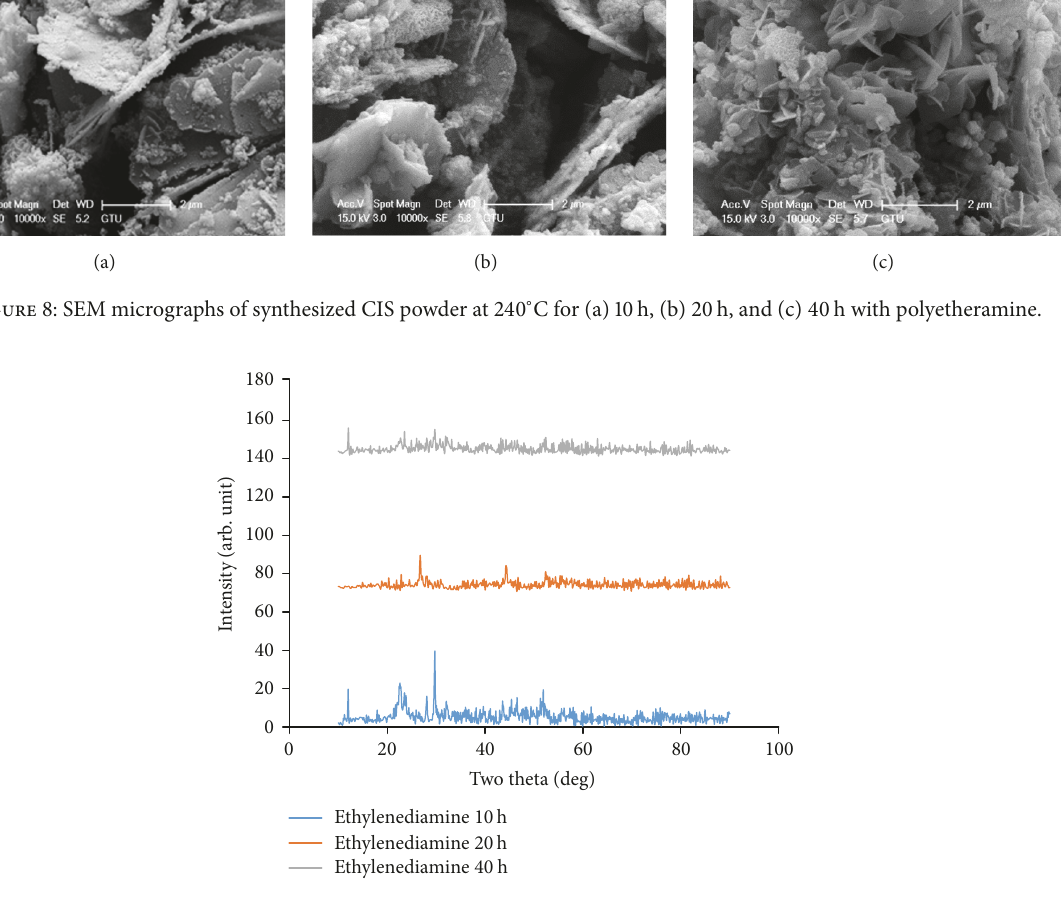
Figure 9: XRD pattern of synthesized CIS powder at 240 ∘ C for 10, 20, and 40 hours with ethylenediamine.